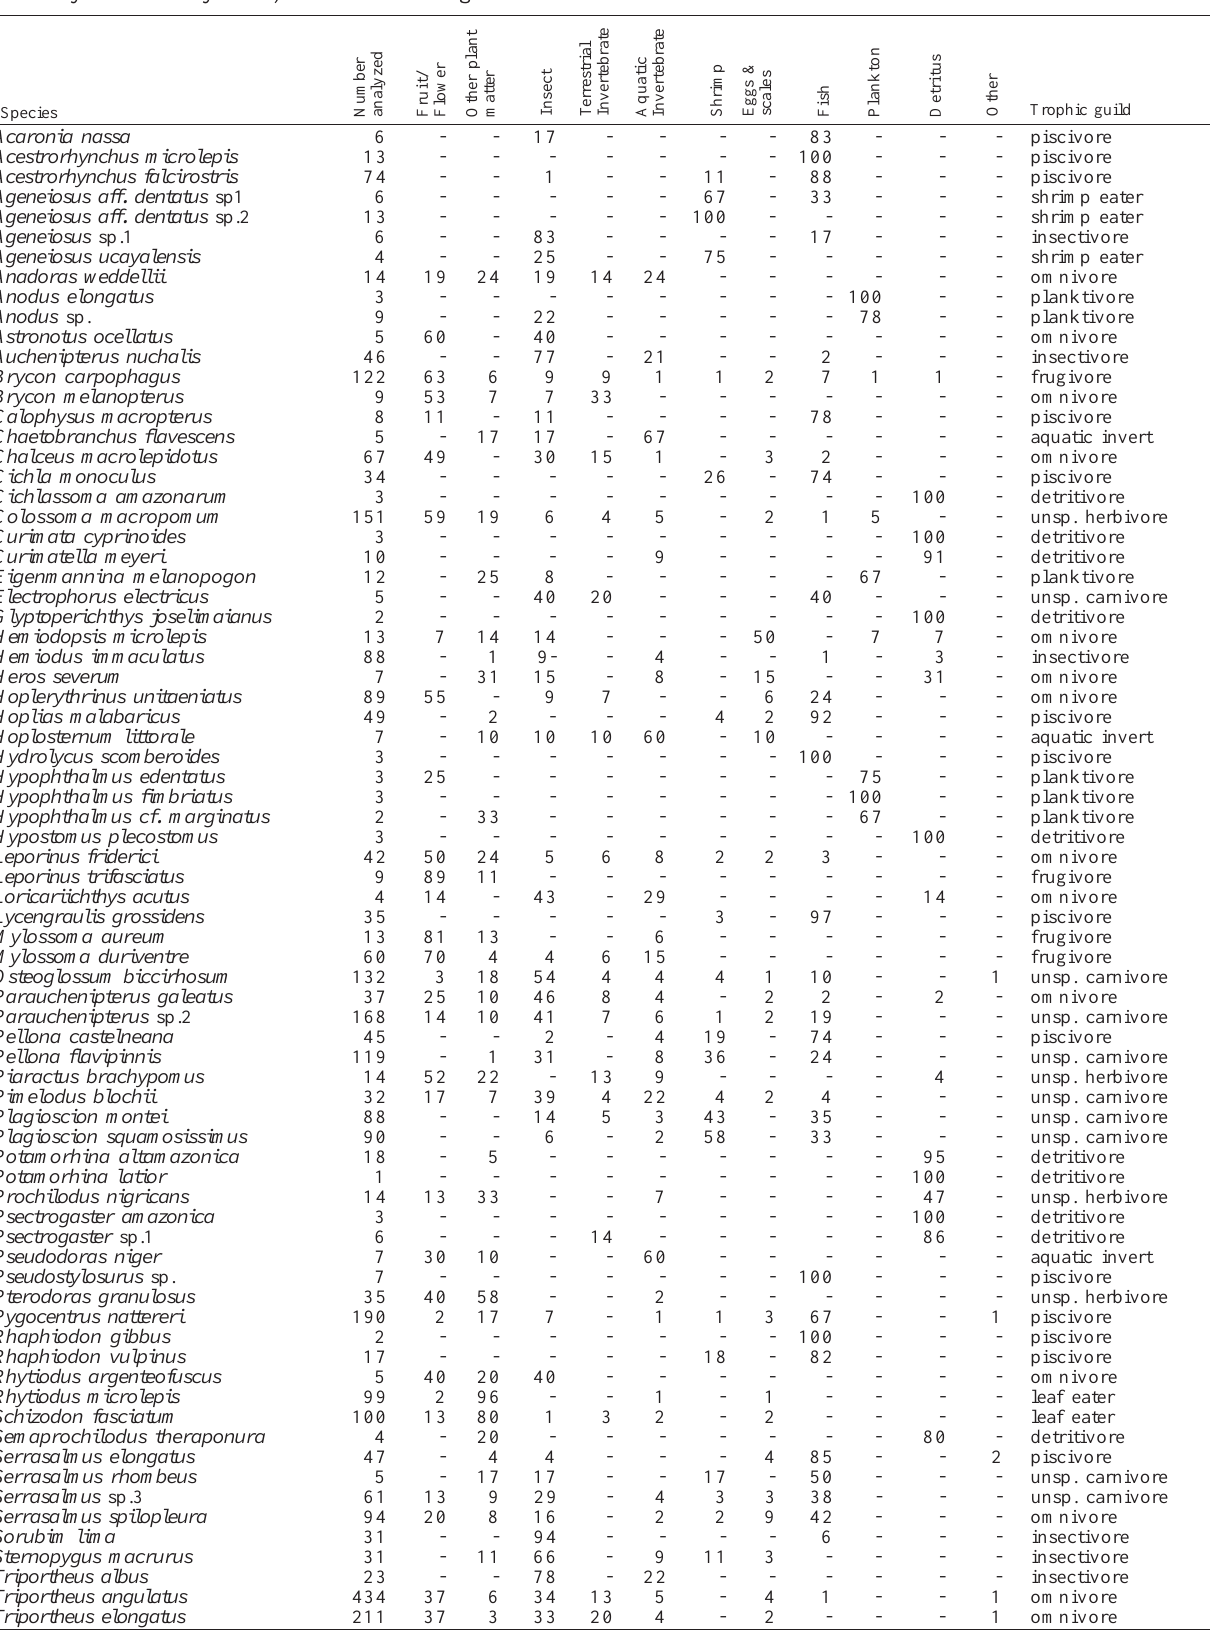
Table 1. Relative abundance (percent) of food items observed in stomachs of 74 species captured in lago do Rei, Brazil, February 1986 to May 1988, and attribution to